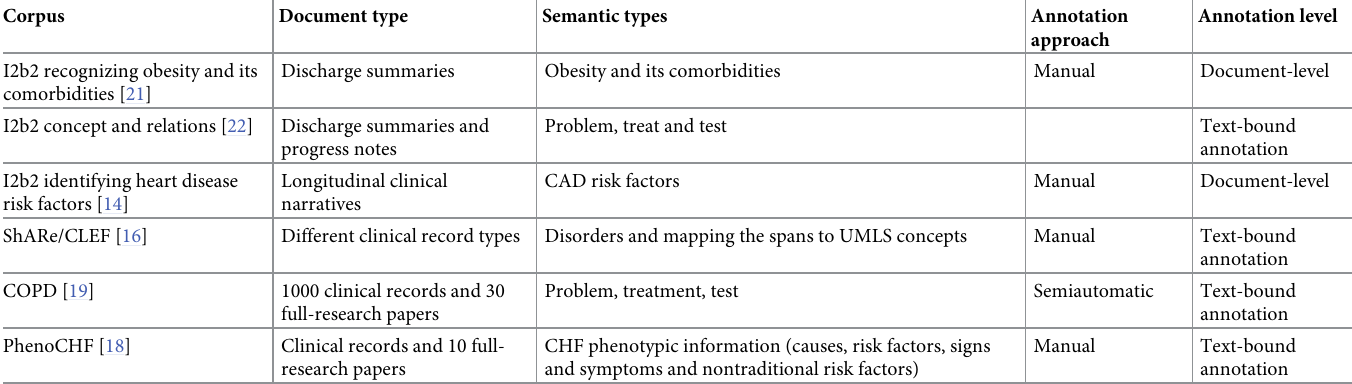
Table 1. Summary of the characteristics of some of the well-known corpora in the clinical